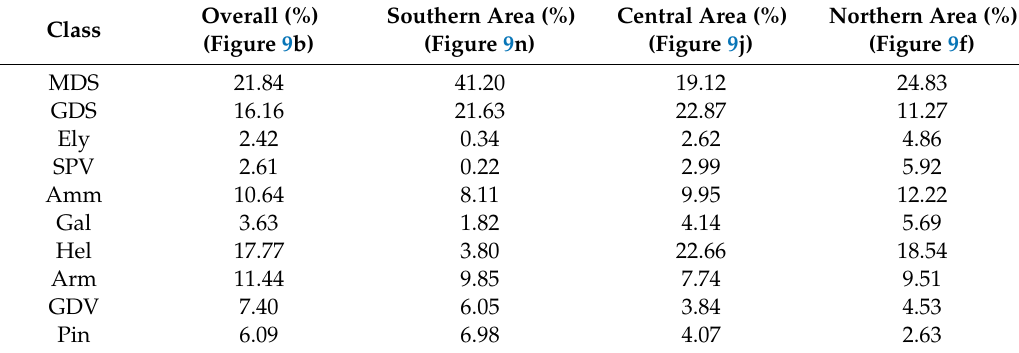
Table 6. Percentage of presence of each class of the di ff erent areas of Figure